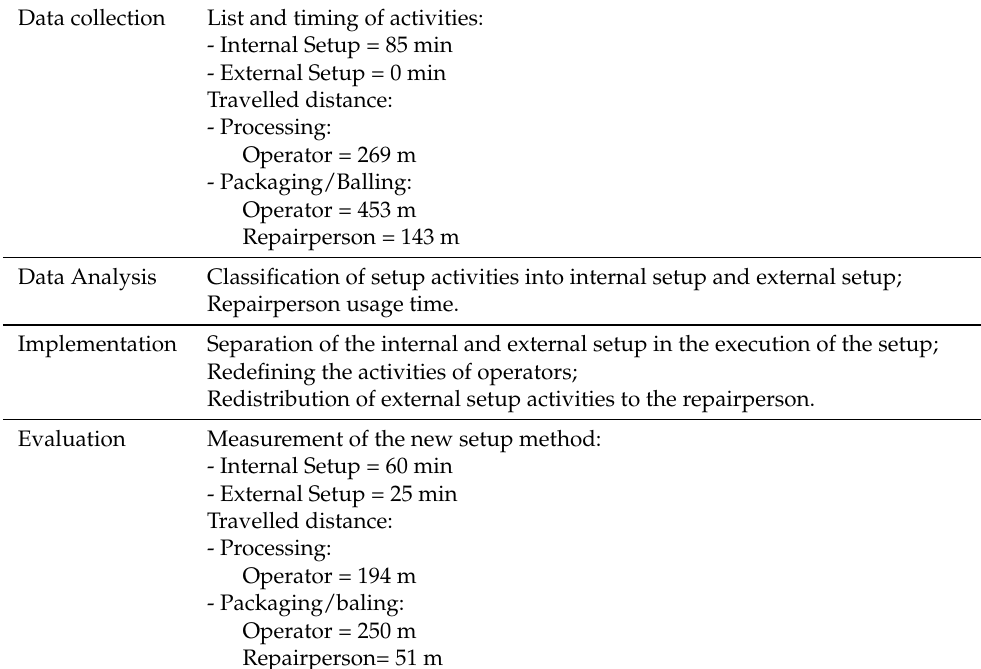
Table 2. Summary of the first cycle of action